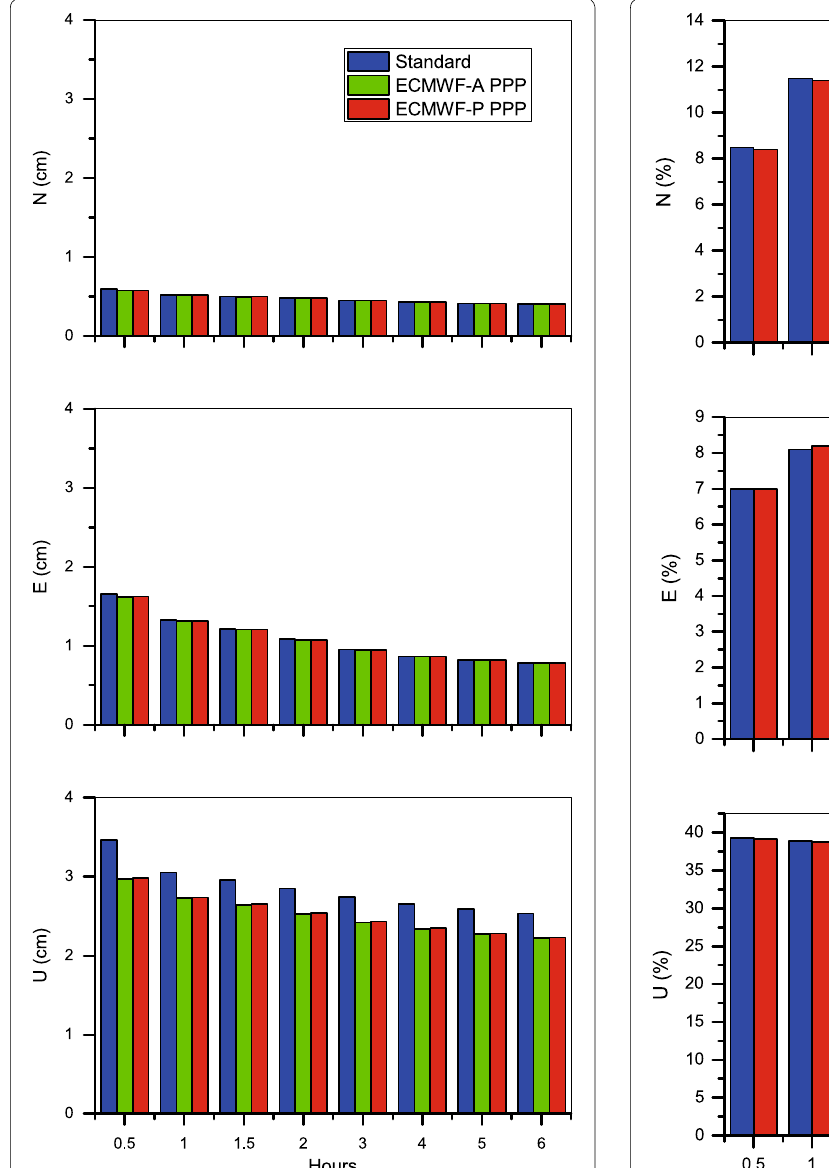
Fig. 6 RMS values of BeiDou/GPS PPP results for the north/east/ up components after the processing of different session length (0.5, 1, 1.5, 2, 3, 4, 5, 6 h) from the BeiDou stations in Fig. 1 over a sample period from February 6 to March 8, 2016. Blue stands for the standard PPP solution, green and red denote the ECMWF-augmented PPP solution with analysis and prediction data, respectively